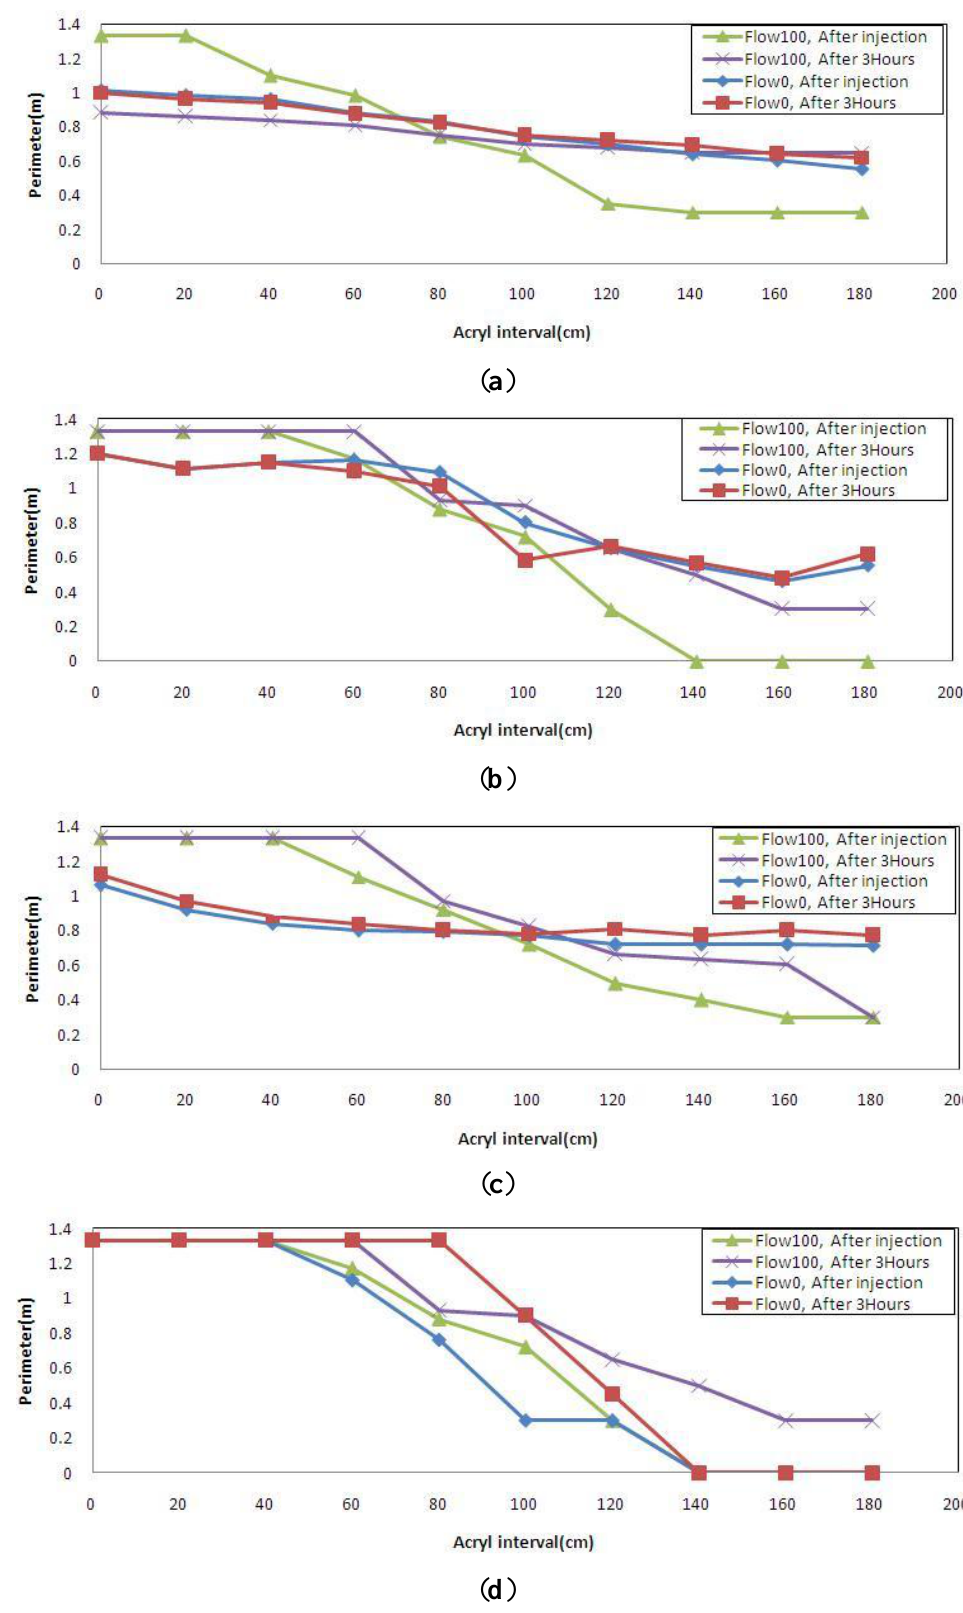
Figure 9. Injection pattern depending on approach speed. ( a ) general low viscosity type; ( b ) general high viscosity type; ( c ) quick-setting low viscosity type; ( d ) quick-setting high viscosity